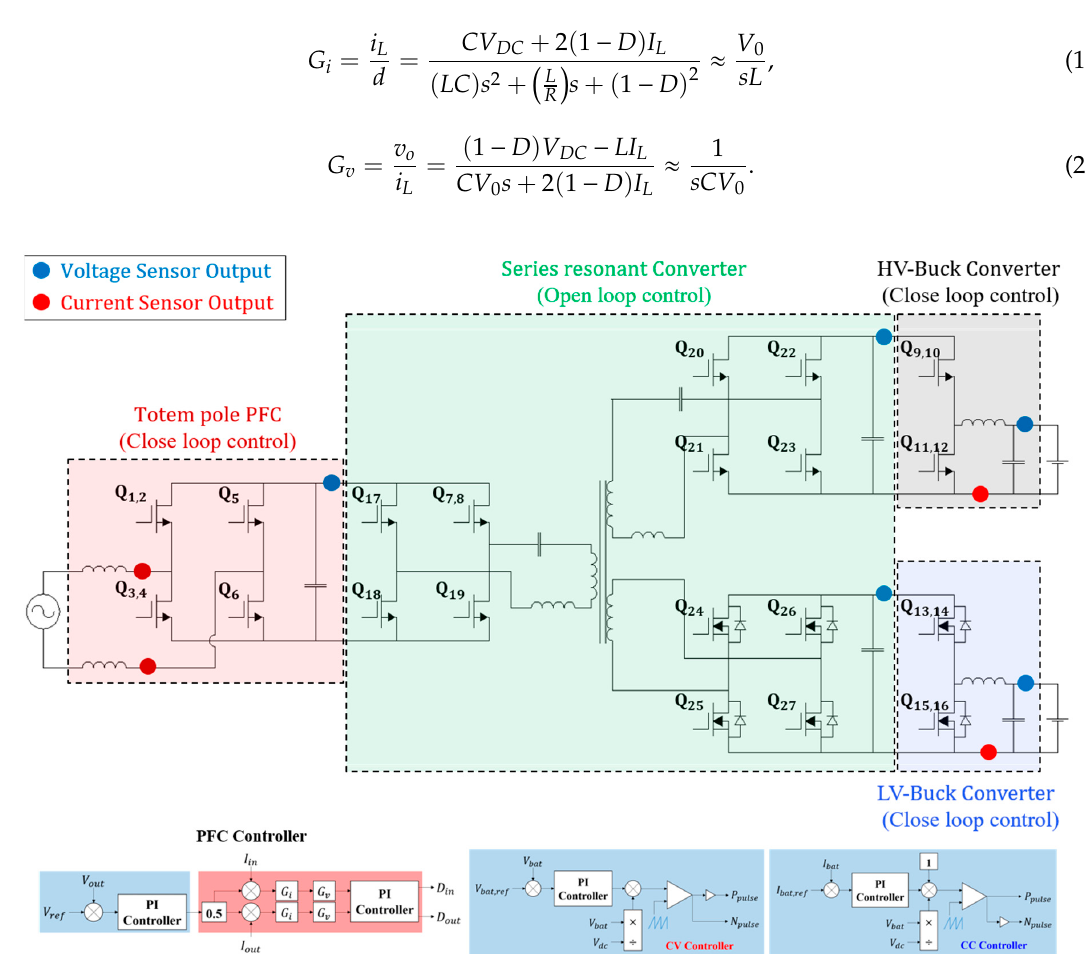
Figure 2. Circuit diagram of the designed 7.2 kW integrated bidirectional OBC/LDC module.